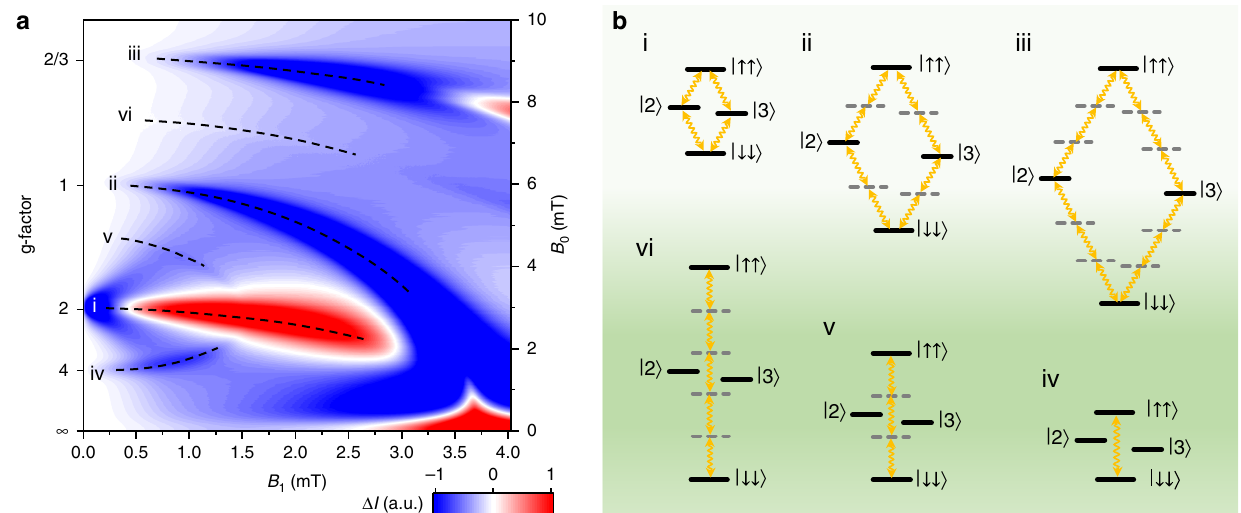
Fig. 2 Floquet spin states in OLED magnetoresistance. a Calculated change of spin-dependent recombination current as a function of static fi eld B 0 and oscillating fi eld B 1 for a frequency of 85 MHz. b Term diagrams of integer and fractional g-factor multi-photon transitions. (i – iii) Δ m ¼ 1 transitions; (iv – vi) Δ m ¼ 2 transitions.